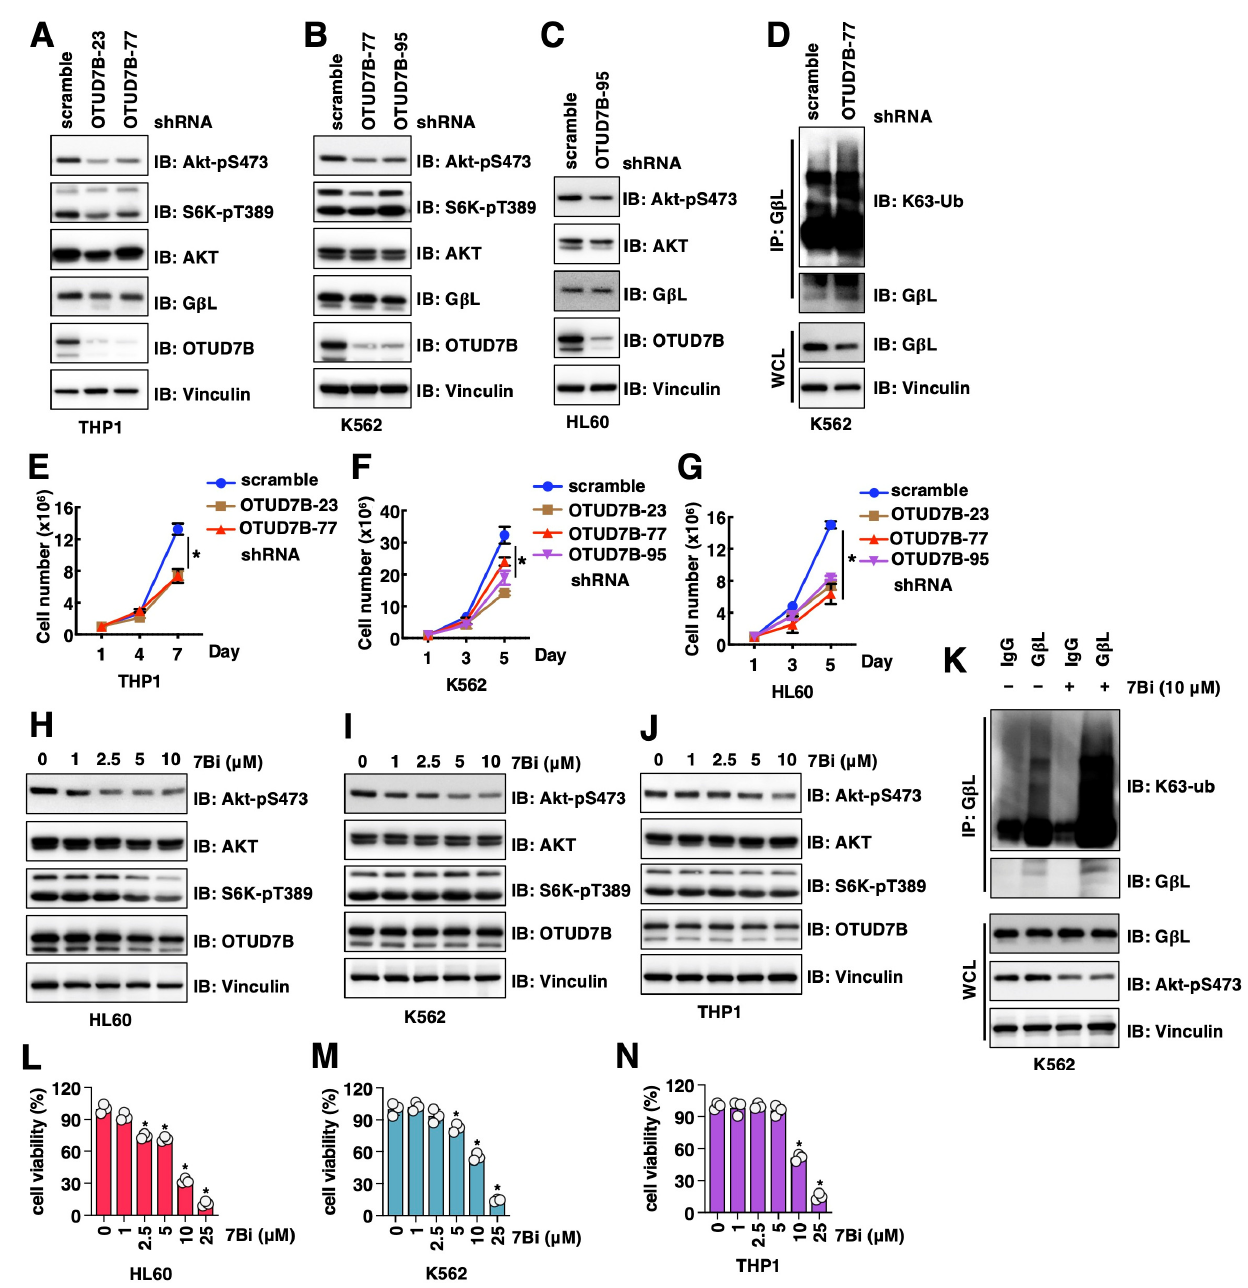
Figure 4. OTUD7B inactivation suppresses leukemia cell proliferation. ( A – C ) IB analyses of WCL from indicated cells with depletion of OTUD7B by shRNAs. ( D ) IB analyses of G β L-IP and WCL from indicated K562 cells. ( E – G ) Quantifications of cell viability by MTT assays in indicated cells treated with indicated doses of indicated compounds for 72 h. Error bars were calculated as mean ± SD, n = 3. * p < 0.05 (one-way ANOVA test). ( H – J ) IB analyses of WCL from indicated cells treated with indicated doses of 7Bi for 16 h. ( K ) IB analyses of G β L-IP and WCL from K562 cells treated with control or 10 μ M 7Bi for 16 h. ( L – N ) Quantifications of cell viability by MTT assays in indicated cells treated with indicated doses of indicated compounds for 72 h. Error bars were calculated as mean ± SD, n = 3. * p < 0.05 (one-way ANOVA test).